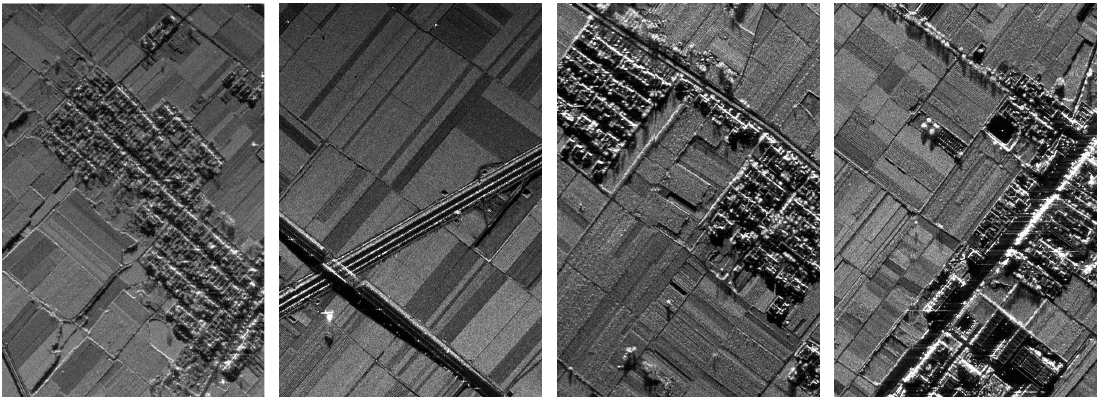
Figure 3. Four SAR images from the Pucheng dataset.